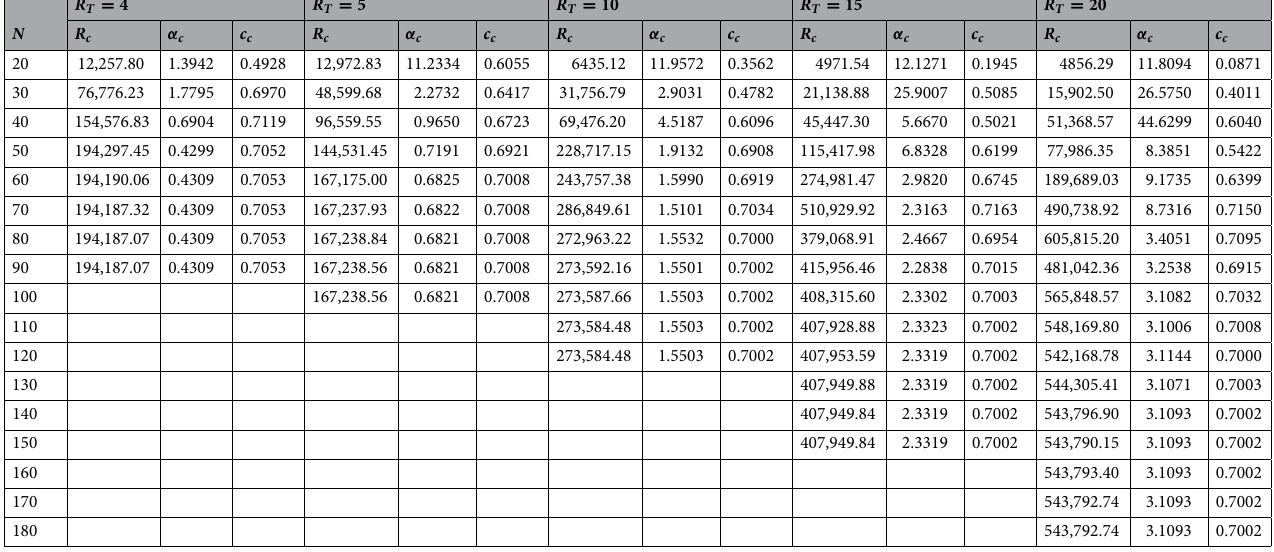
Table 1. Convergence process of the Chebyshev collocation method for different values of R T